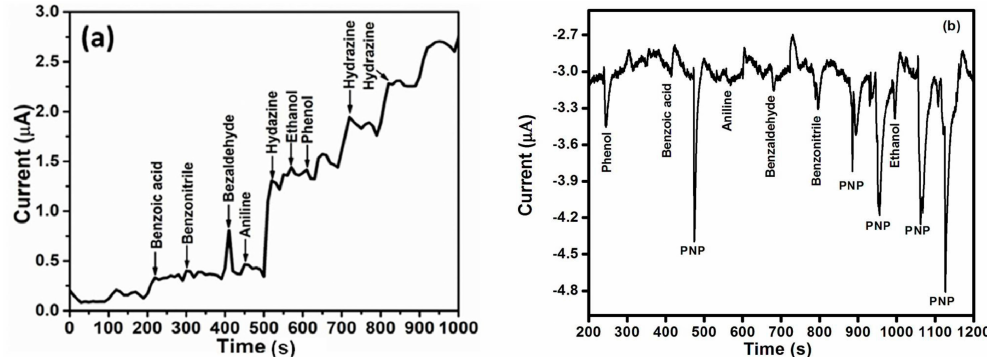
Figure 8. Amperometric response of the Gd 2 O 3 / Au electrode in the presence of di ff erent analytes with a concentration of 1 mM at pH 7 for ( a ) hydrazine and ( b )